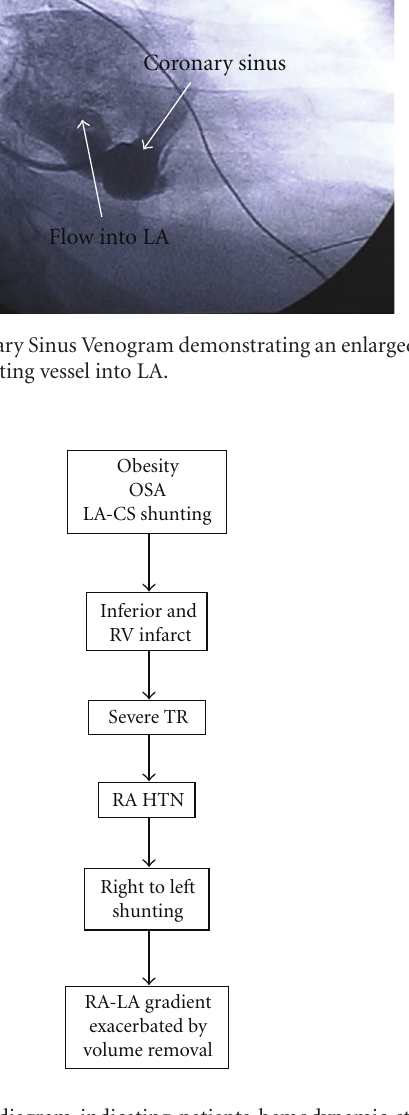
Figure 6: Flow diagram indicating patients hemodynamic status resulting in severe left-to-right